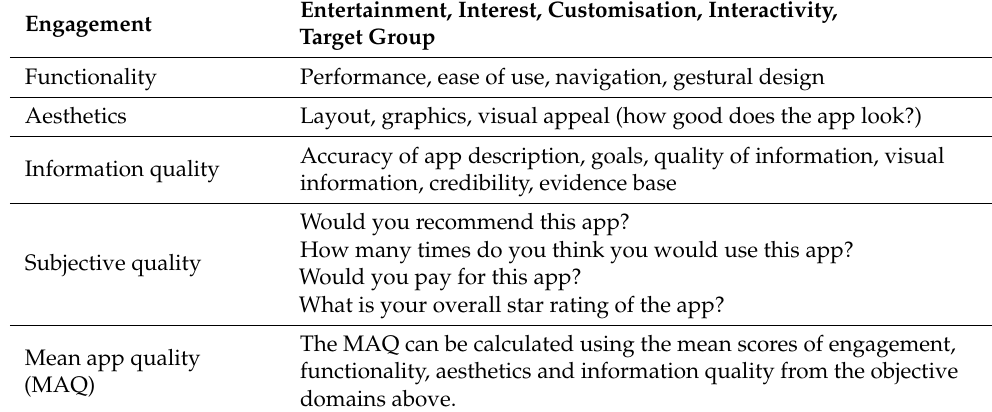
Table 2. Five domains of the mobile app rating scale (MARS) and the associated ‘descriptor terms’ to prompt scoring on a 5-point Likert scale. There are four objective domains (engagement, functionality, aesthetics, information quality) and one subjective domain (subjective quality). Modified from Stoyanov et al.